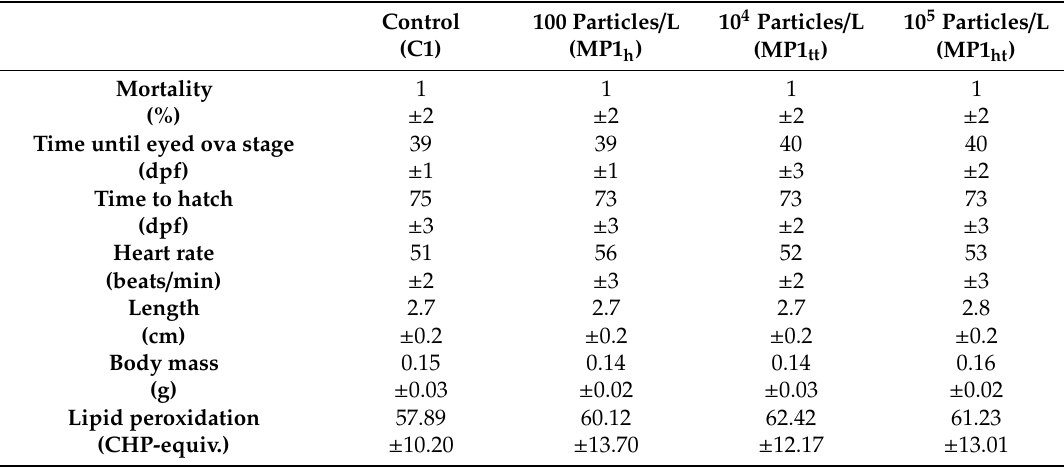
Table 1. Summary of data for the investigated endpoints in experiment 1a. All data are given as arithmetic means ± standard